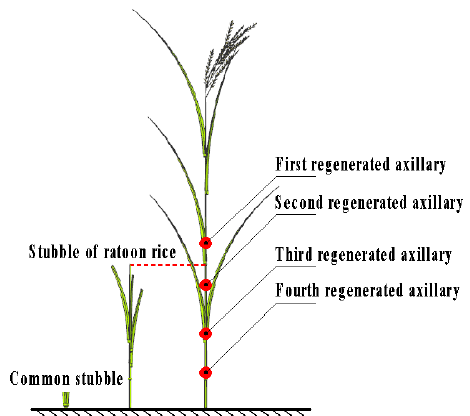
Figure 2. Stubble height of rice plant after the first-season harvest.